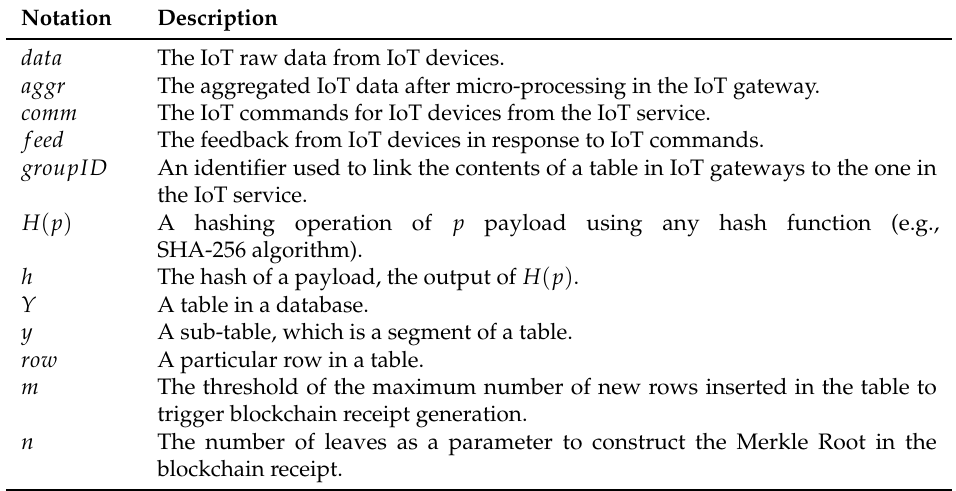
Table 5. The list of new notations introduced in our data at rest design.